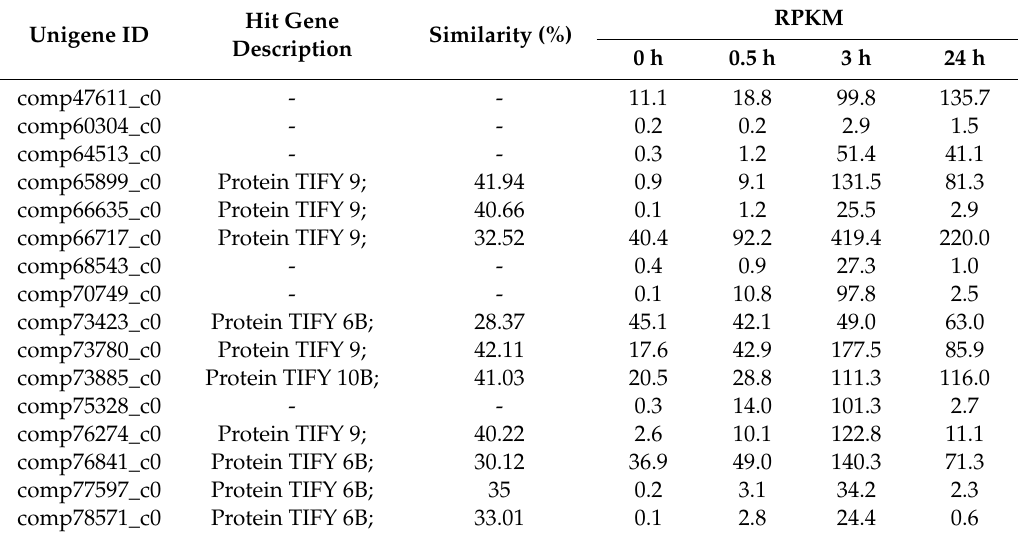
Table 1. List of suspected JAZ genes in the Tm_ZK transcriptome.